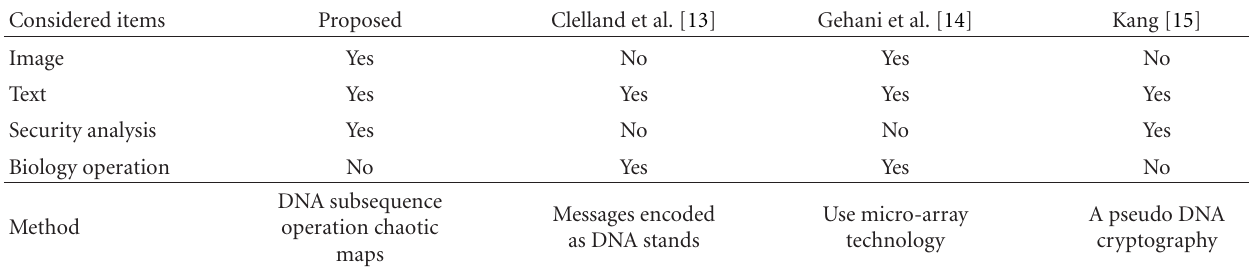
Table 3: Comparison with other DNA-based encryption